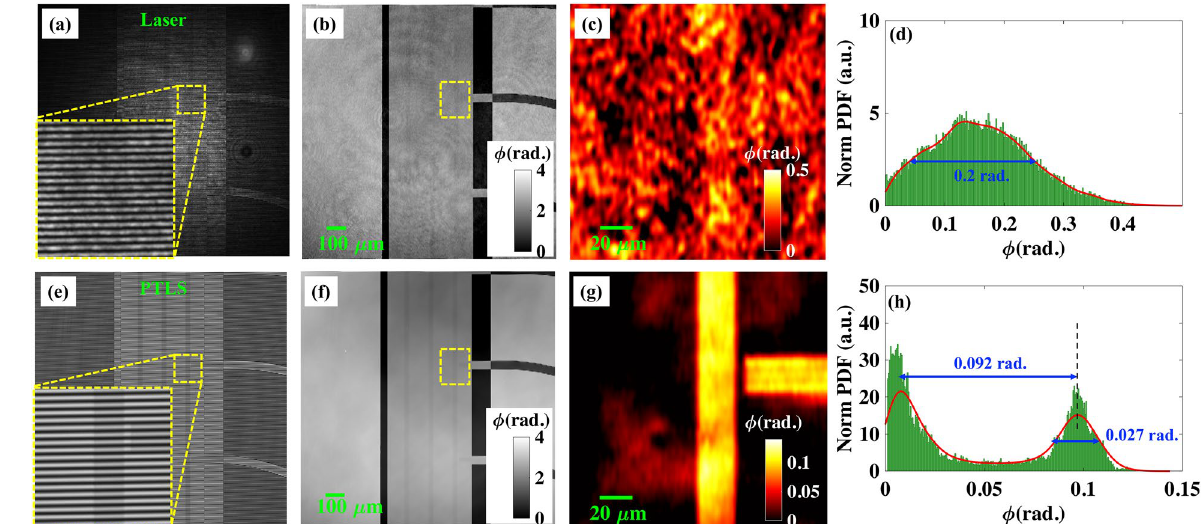
Figure 4. PTLS produces high quality phase images of optical waveguide of 8 nm rib height. ( a , e ) Interferometric images of Si 3 N 4 optical waveguide while using diode laser (at 638 nm) and PTLS, respectively. The insets depict the zoomed view of the region marked with yellow dotted box. ( b , f ) Reconstructed full FOV phase maps of an optical waveguide (H ~ 8 nm) corresponding to diode laser and PTLS, respectively. ( c , g ) Zoomed views of the regions marked with yellow dotted boxes in the reconstructed phase images depicted in ( b ) and ( f ), respectively. ( d , h ) The histogram plots of the phase images shown in ( c ) and ( g ), respectively. It can be visualized that the PTLS produces superior quality phase images of the waveguide compared to diode laser. The thin rib height of ~ 8 nm is not visible and embedded in the coherent noise of the QPM system in case of diode laser. The color bars are in